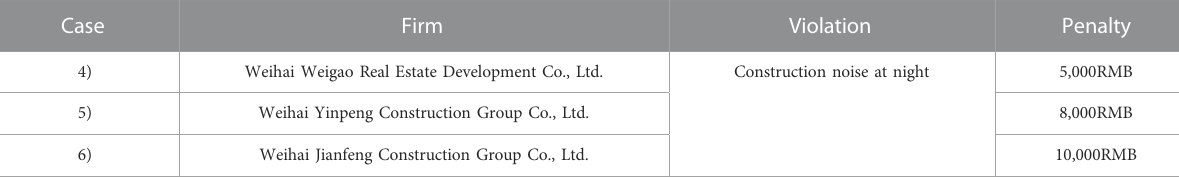
Table 1. Article 48 of Law of the People ’ s Republic of China on